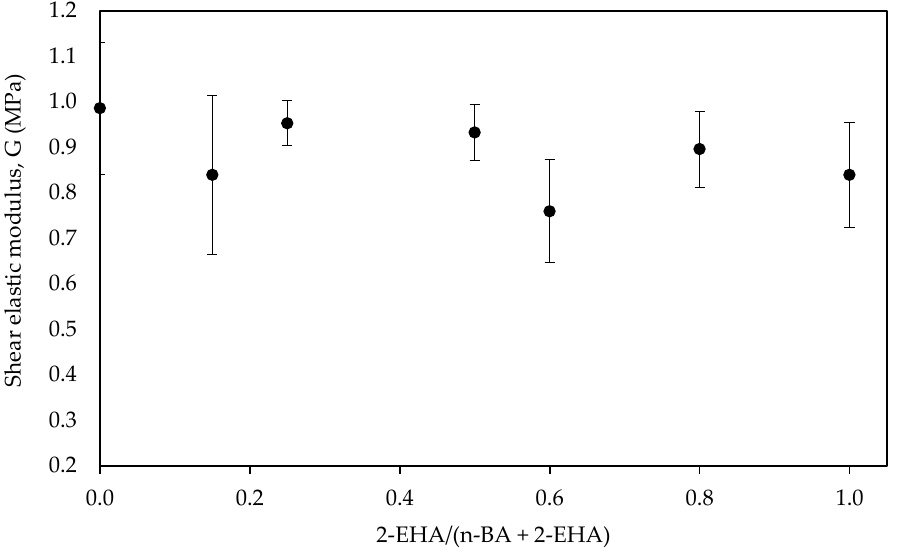
Figure 7. Shear elastic modulus versus the co-monomer ratio.